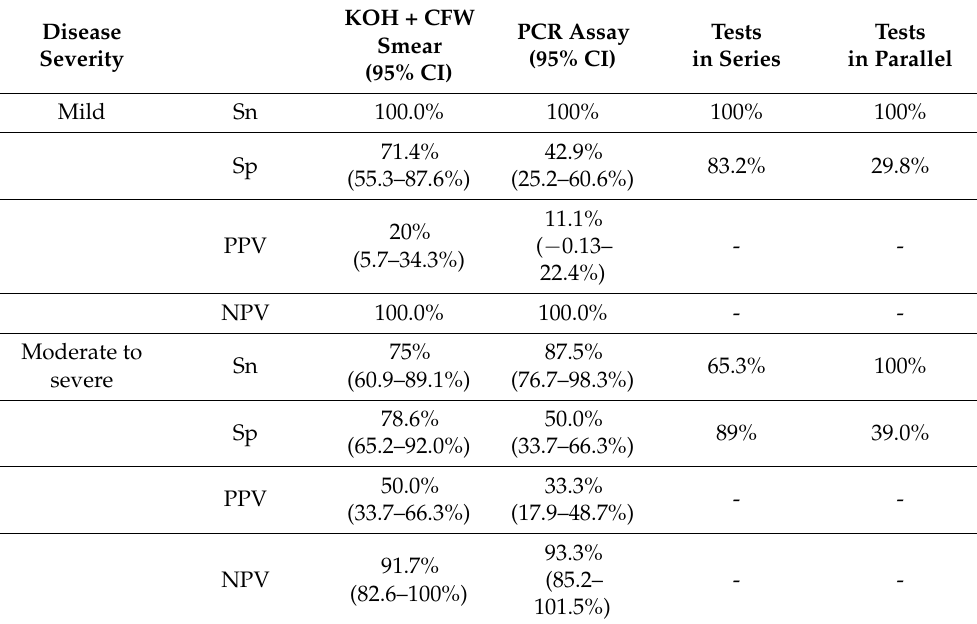
Table 4. Comparision of diagnostic performance of KOH + CFW smear and PCR assay (Sensitiv-